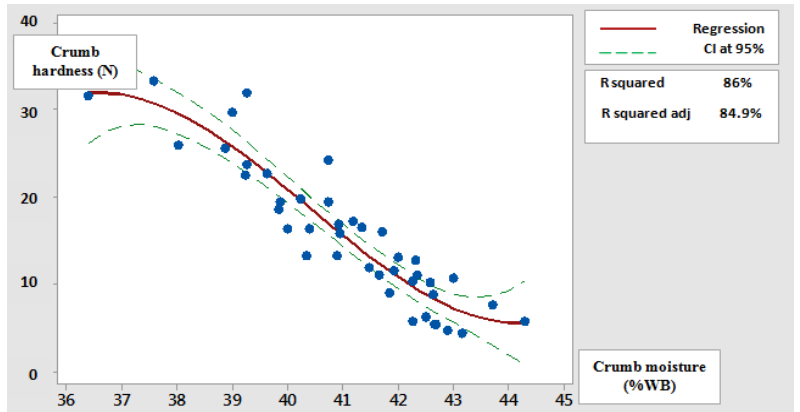
Figure 3. Adjustment of crumb firmness variation function of its moisture content. CI, Confidence Interval; R square adj., Adjusted R-Squared